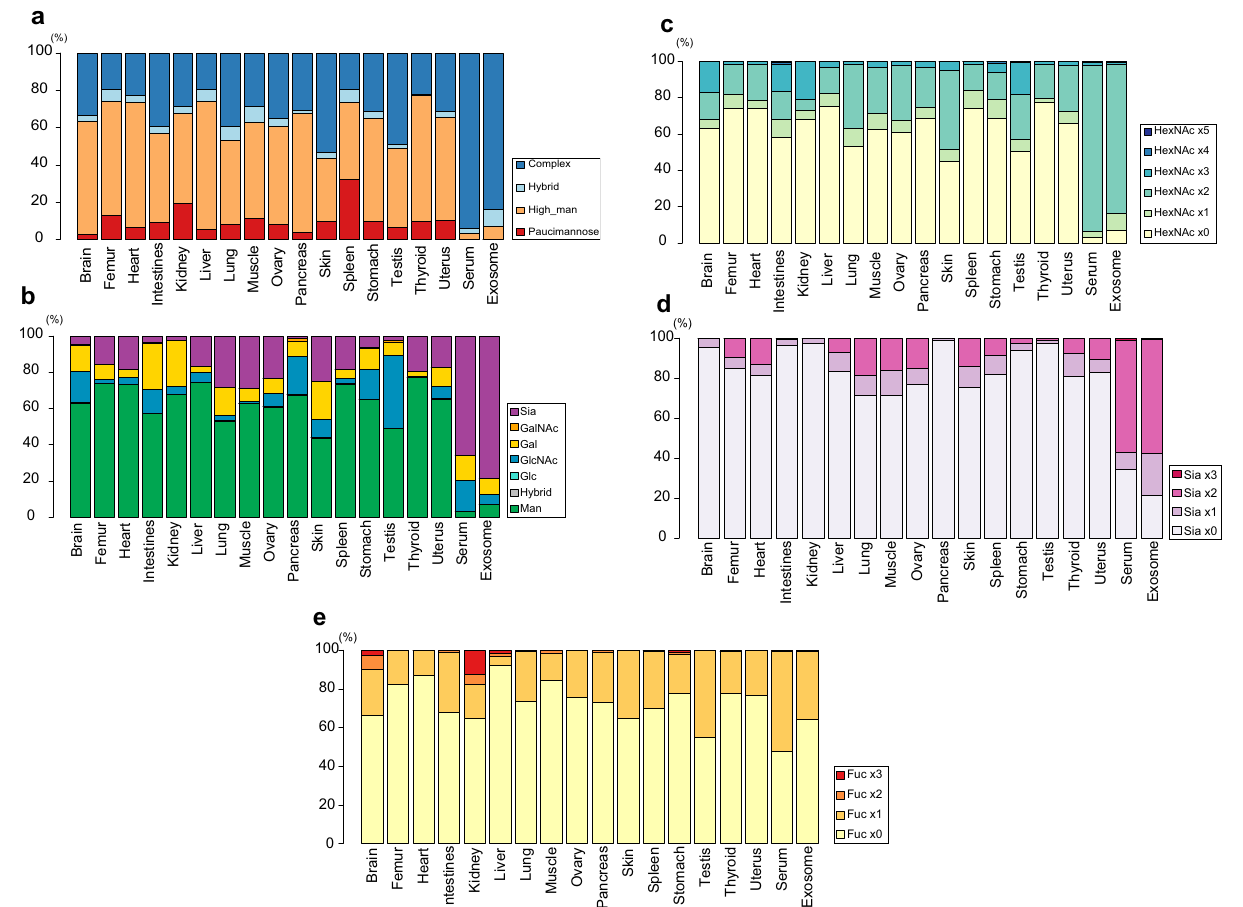
Figure 5. Glycotyping analysis of 103 mouse organ glycoforms based on the general N -glycan taxonomy ( a ), the most matured terminal sugar residue defined by the hierarchy in N -glycan biosynthesis ( b ), the numbers of HexNAc except core structure or the numbers of antennae of the N -glycan structure ( c ), number of sialic acid residue (Neu5Ac and Neu5Gc) ( d ), and number of Fuc ( e ), respectively. Colored columns show the percentages (average of five samples) to total N -glycans estimated in the individual organs except the internal standard compound